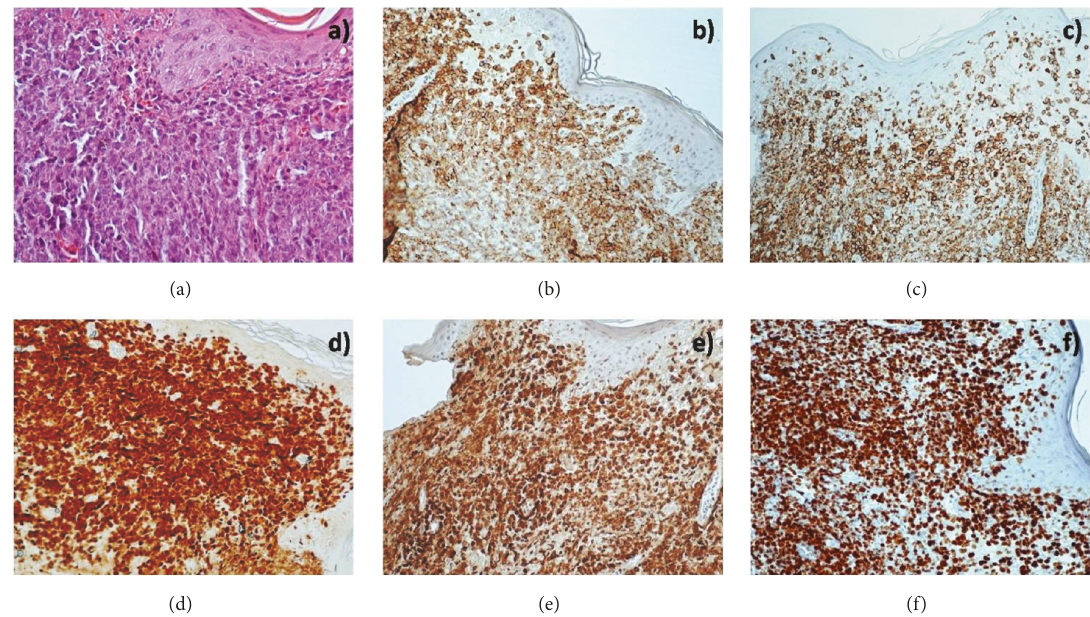
Figure 1: (a) Diffuse infiltration of the dermis by large lymphoid tumor cells with variable proportions of centroblasts and immunoblast- like cells (Hematoxylin-Eosin: magnification X400), (b–e) Positive immunostaining of large tumor cells for CD20, CD5, MUM1, and Bcl2, respectively (magnification X200) and (f) Ki67 immunostaining in approximately 90% of large tumor cells.